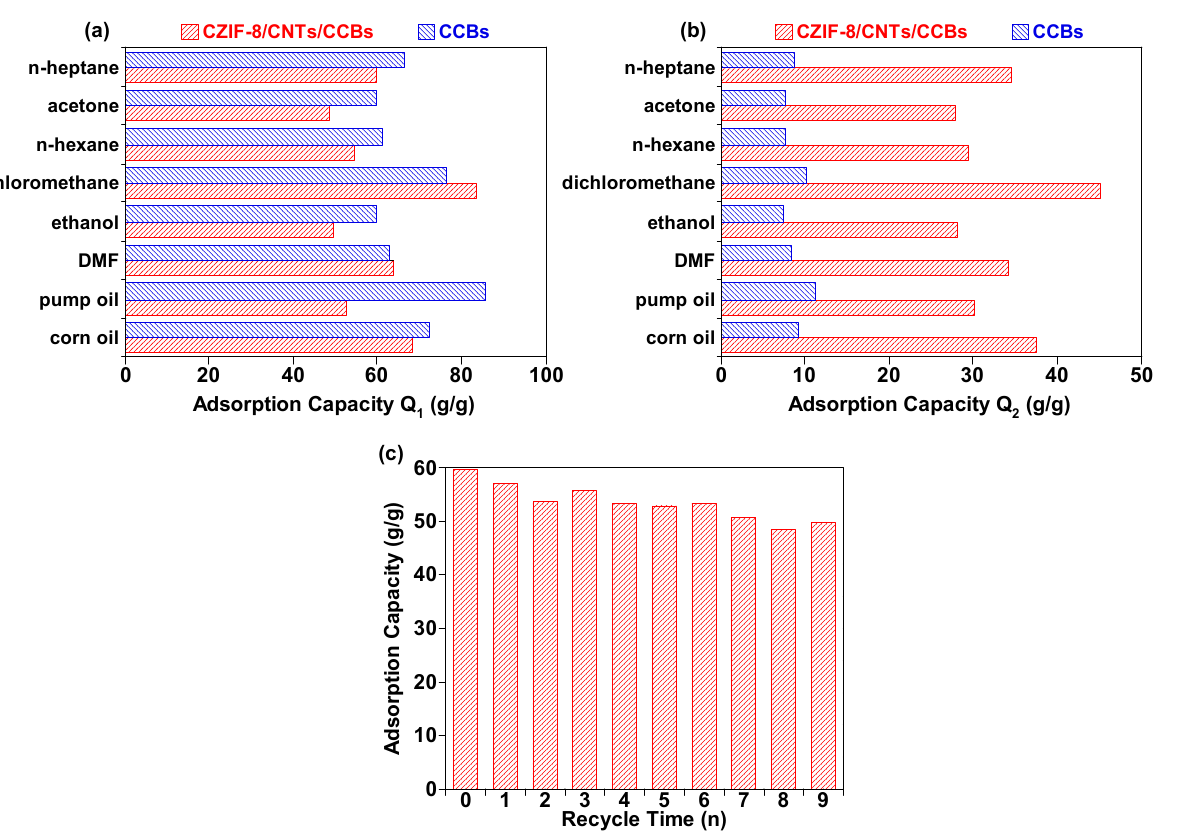
Figure 8. ( a ) Sorption process of dichloromethane (dyed with Oil Red O) by C ZIF-8/CNTs/CCBs. ( b ) Sorption process of n-hexane (dyed with Oil Red O) by C ZIF-8/CNTs/CCBs. (a) (b) CZIF-8/CNTs/CCBs CCBs